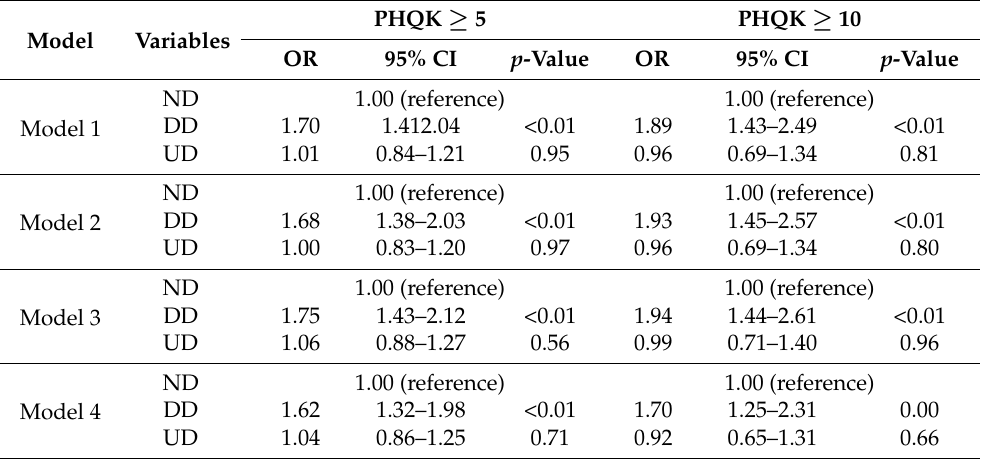
Table 2. Multivariable logistic regression analyses for depression among the total population.